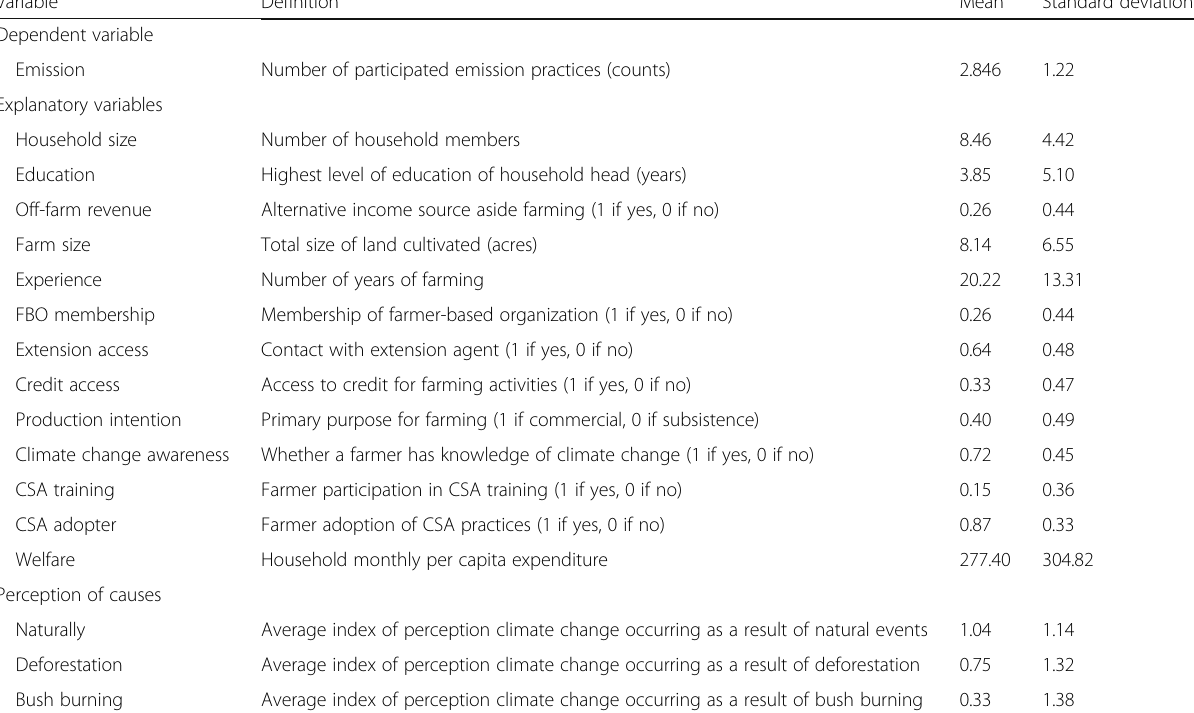
Table 4 Variable definition and descriptive statistics